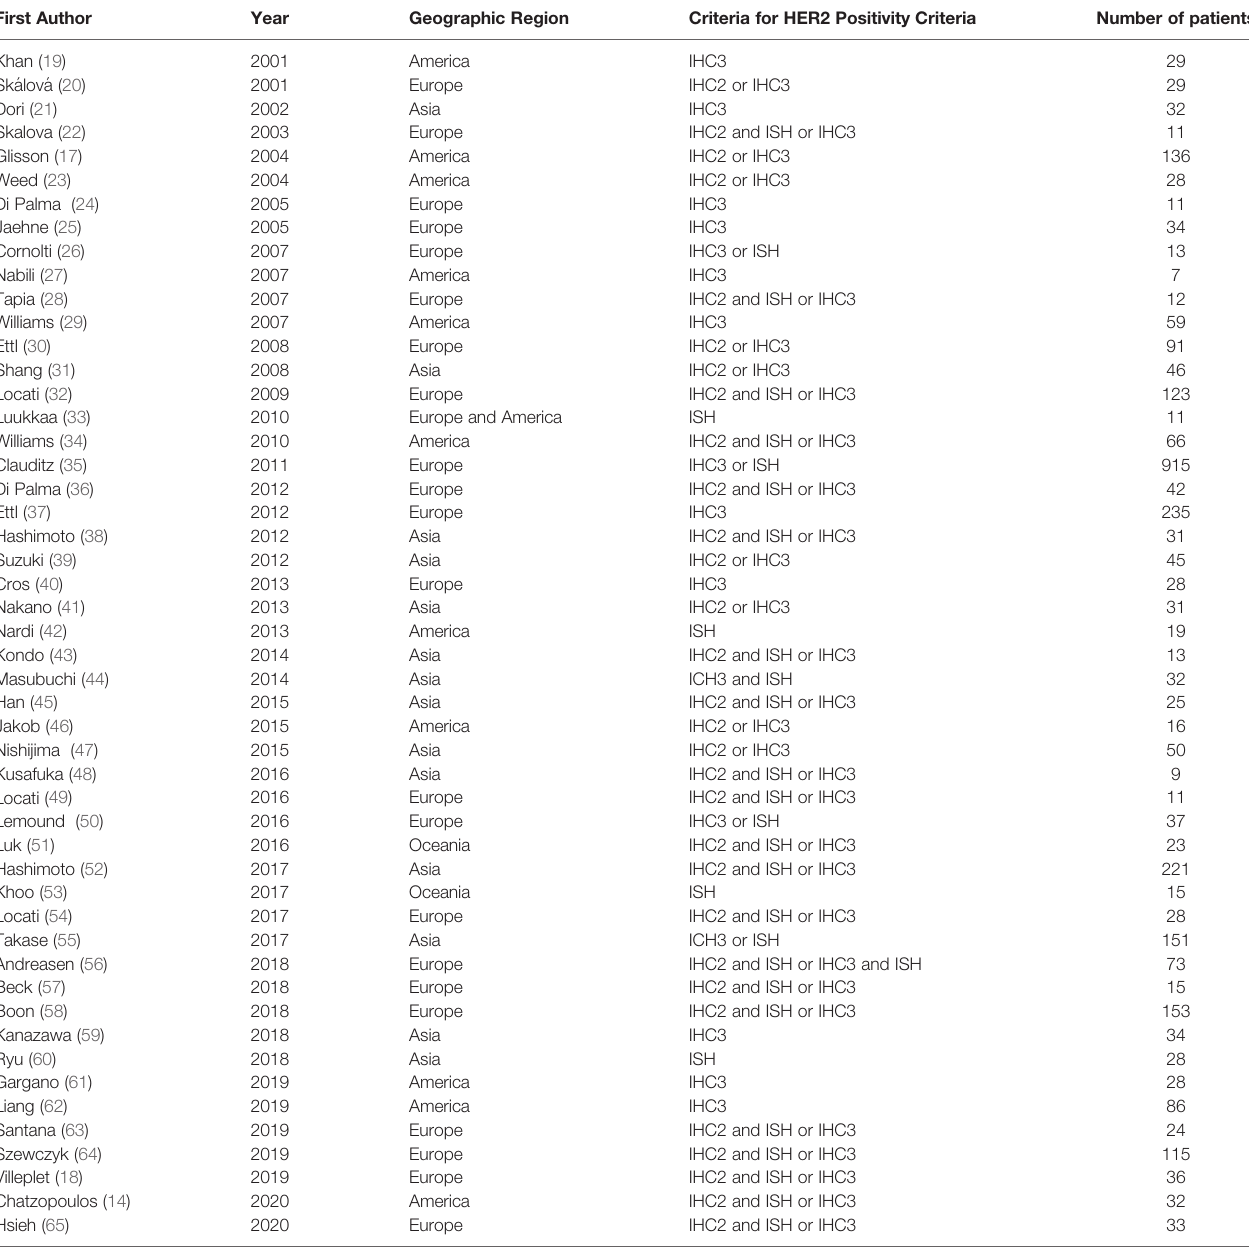
TABLE 1 | Studies included in the